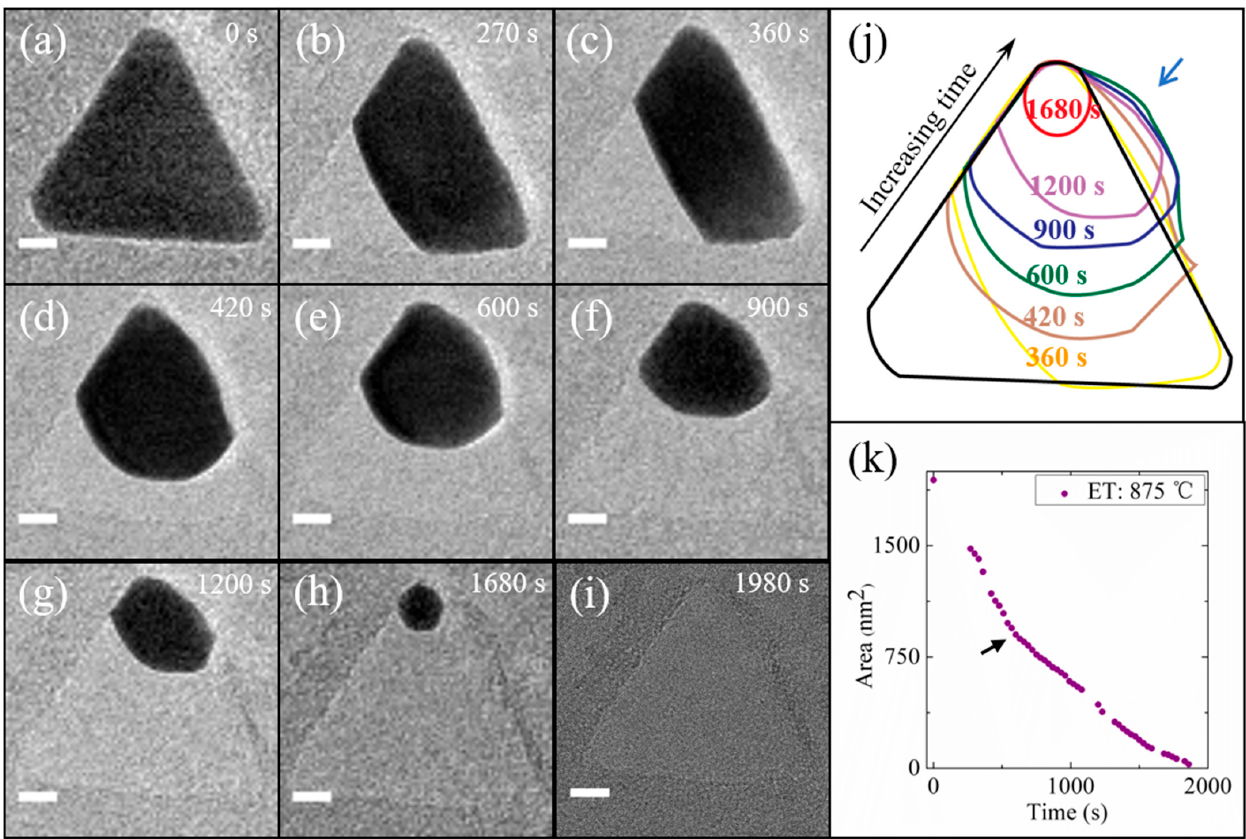
Figure 2. Evaporation kinetics and shape reconstruction. ( a – i ) Time-lapse TEM images of the same nanoprism as the one in Figure 1 recorded at 0, 270, 360, 420, 600, 900, 1200, 1680 and 1980 s, respectively, after the temperature was elevated to 875 °C. ( j ) A contour illustrating the shape change of the nanoprism at various heating times ( a – i ). The arrow indicates the migration of the nanoprism out of its original position owing to the shape reconstruction. ( k ) The change of projection areas of the nanoprism during the evaporation process. The area change does not exhibit a linear relationship with heating time. The arrow marked at 540 s indicates the transition point of evaporation rates. ET: Experimental temperature. Scale bars for ( a – i ): 10 nm.